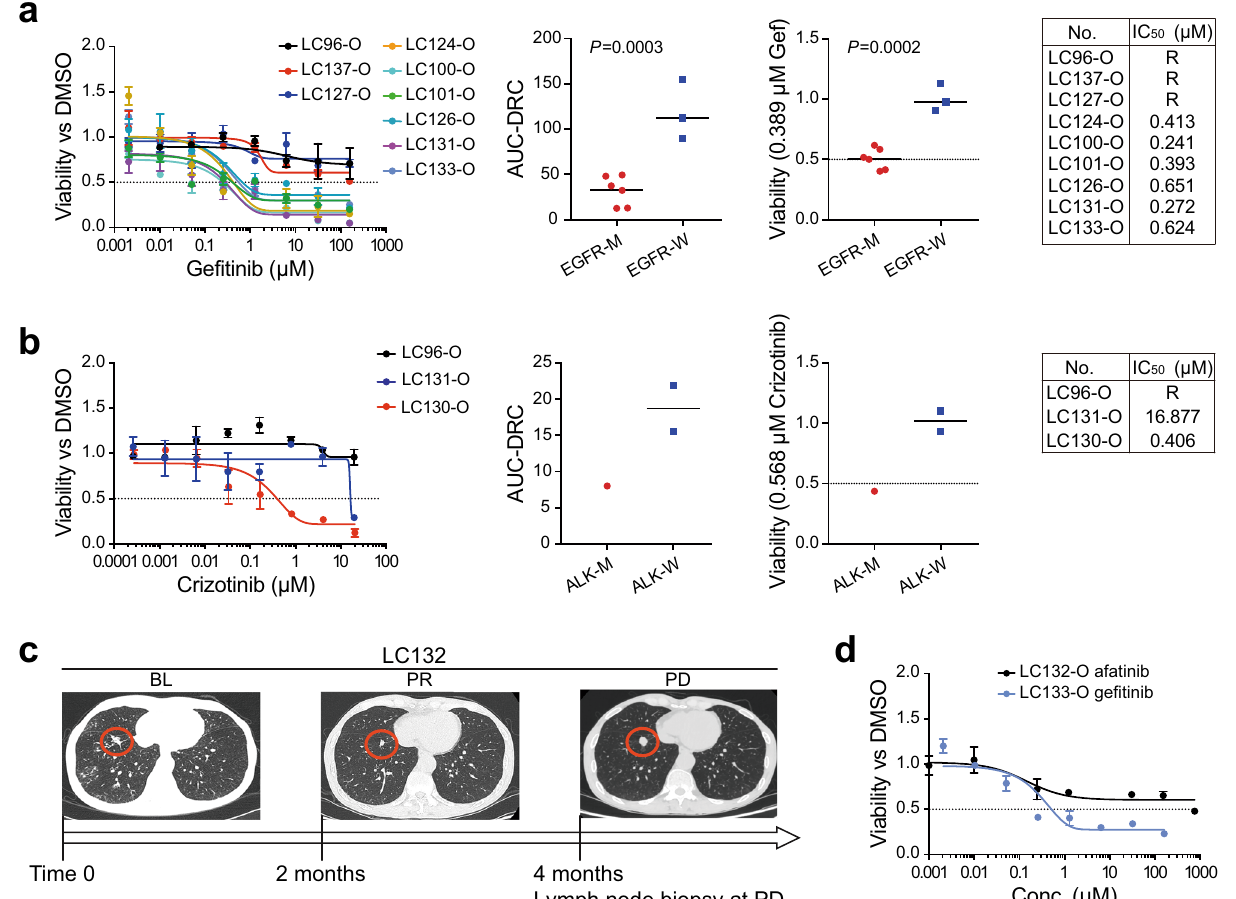
Fig. 5 LCO-based 1-week drug sensitivity tests re fl ect the response of lung cancers to targeted drugs. a Responses of LCOs to the TKI inhibitor, ge fi tinib, in agreement with EGFR mutations. The fi tted dose – response curves (DRCs) represent the viabilities of nine LCOs exposed to a concentration gradient of ge fi tinib ( n = 3 biologically independent cells, data are presented as mean ± SD). Three of the LCOs have wild-type EGFR and the other six harbor EGFR activation mutations sensitive to TKI inhibition. For both the area under the dose – response curve (AUC-DRC) and the viability C trough , the EGFR mutation (EGFR-M) and the EGFR wild-type (EGFR-W) groups were compared using the unpaired two-tail Student ’ s t test. The IC 50 values listed in the table were interpolated from the fi tted dose – response curves. R means IC 50 is not available since the viability of the LCO is >50% under all the concentrations. b Responses of LCOs to crizotinib (ALK inhibitor). The organoid with the EML4-ALK rearrangement mutation (ALK-M: LC130-O) shows reduced viabilities, while those with the wild-type type of ALK (ALK-W: LC96-O and LC131-O) have no responses ( n = 3 biologically independent cells, data are presented as mean ± SD). c CT scan images showing the lung tumor that developed resistance to afatinib as the primary tumor grew (red circles) and cervical lymph node metastases were developed in the course of the treatment. LCOs were generated from the biopsy of cervical lymph node resected at 4 months post the TKI treatment. d Fitted dose – response curves illustrating the distinct responses of LC132-O and LC133-O to TKIs, consistent with the patients ’ responses ( n = 3 biologically independent LCOs, data are presented as mean ±